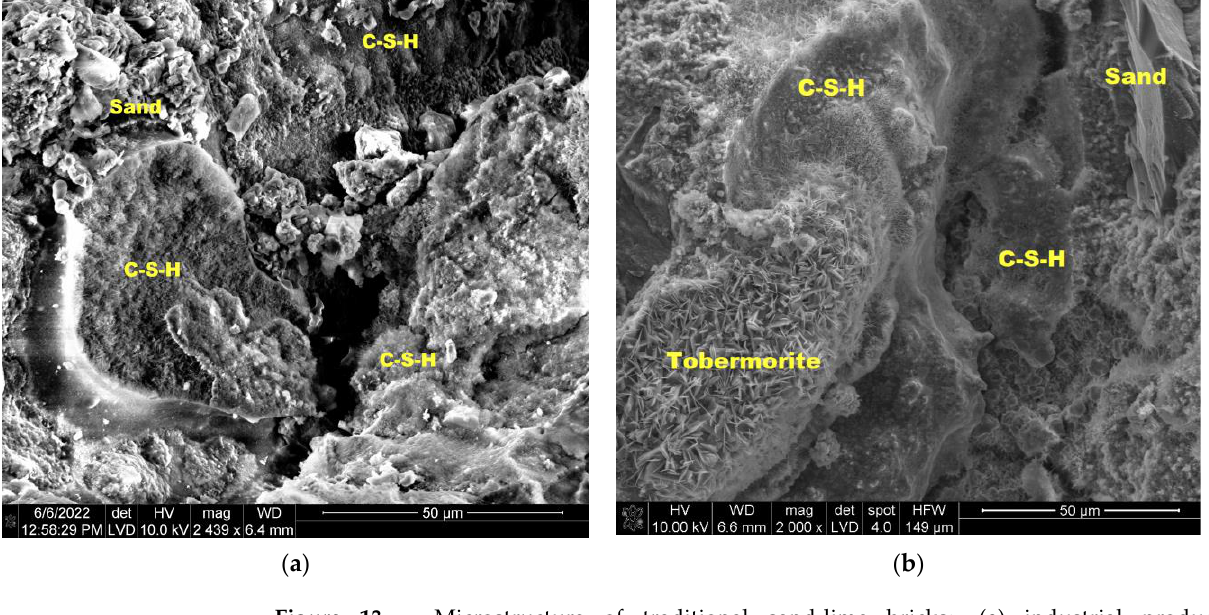
Figure 13. Microstructure of traditional sand-lime bricks; ( a ) industrial production; ( b ) laboratory production.